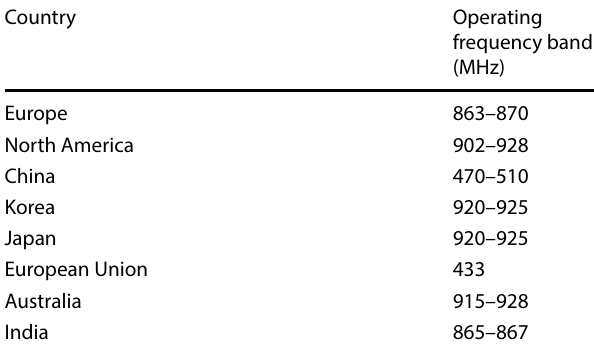
Table 4 Operating frequency of different country [21] Country Operating